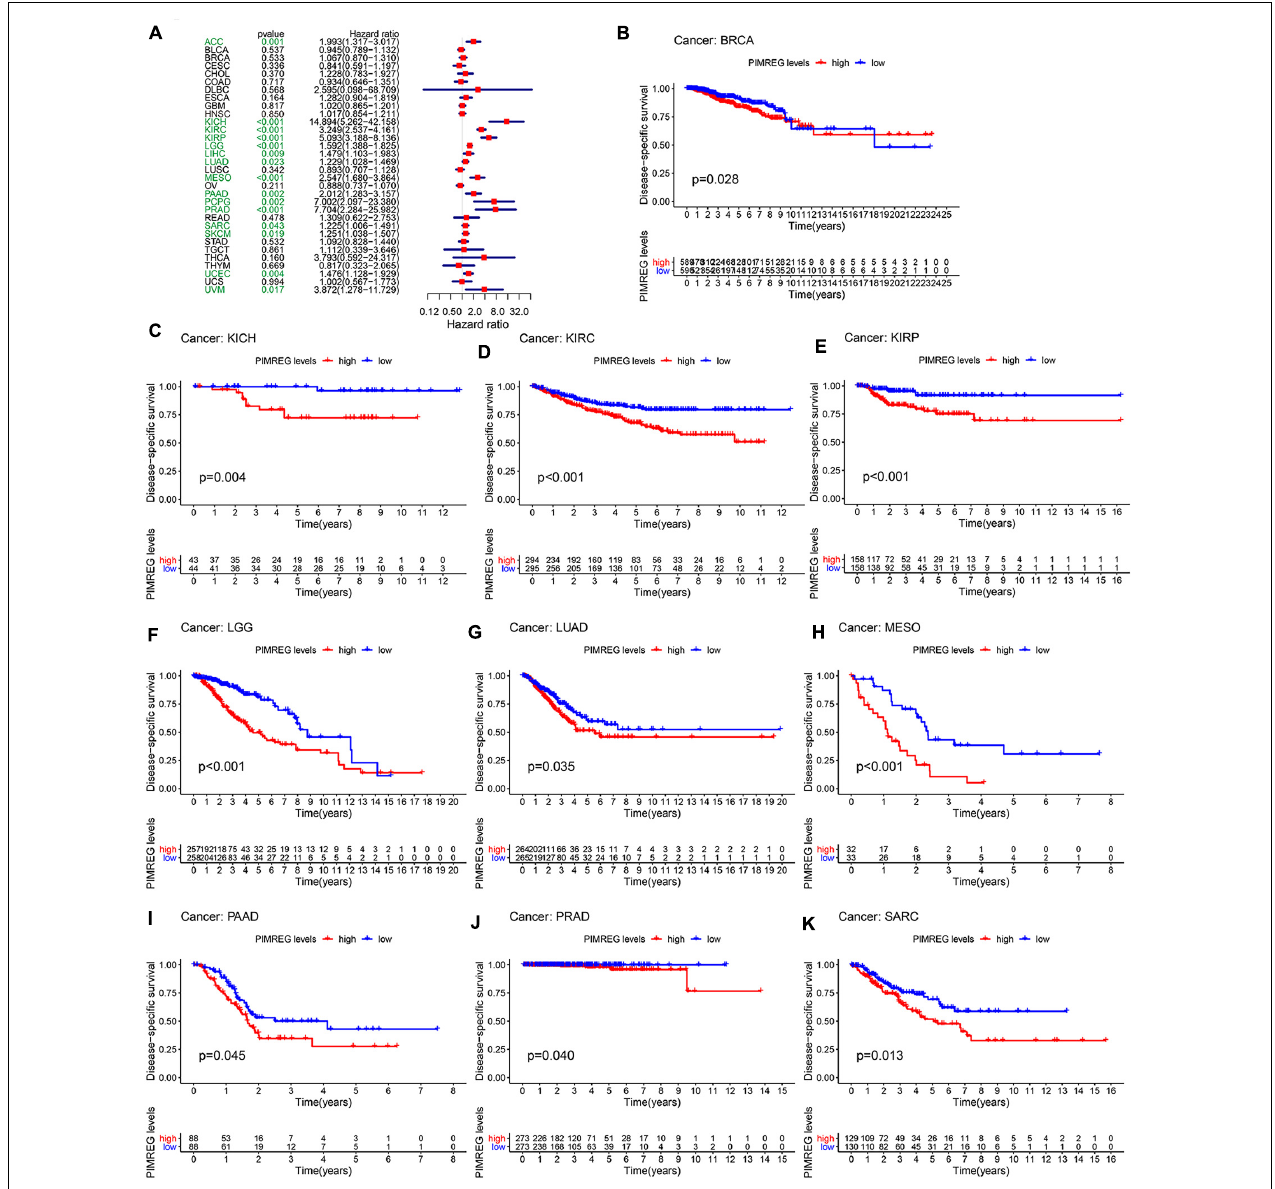
FIGURE 4 | Correlation between the expression of PIMREG and disease-specific survival (DSS). (A) Forest plots of PIMREG expression in 33 tumors in association with DSS. (B–K) KM analyses of the relationship between the expression of PIMREG and